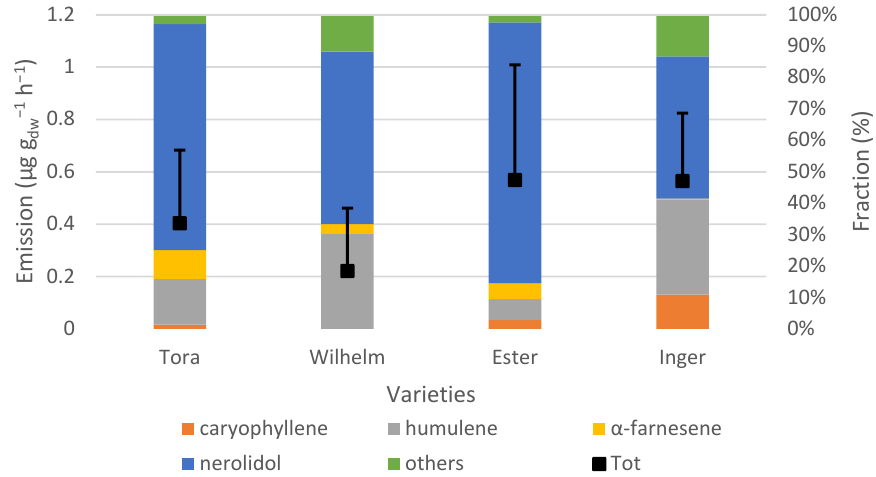
Figure 4. Total SQT emissions (black square, µg g dw − 1 h − 1 , mean + standard deviation, n = 52–104) and the contribution from each SQT for the different varieties. Others includes copaene and one unknown compound .